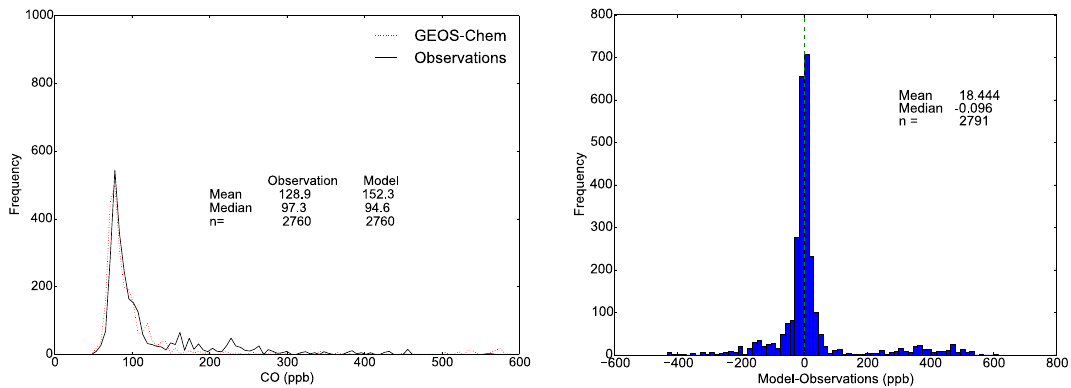
Figure 2. Statistical comparison of model and observed CO from BORTAS-B. The observations have been averaged over the 2 ◦ × 2.5 ◦ model grid. Left-hand panel shows the frequency distributions; right-hand panel show the frequency distribution of the model minus observed CO residuals. Mean and median values are shown on each panel.